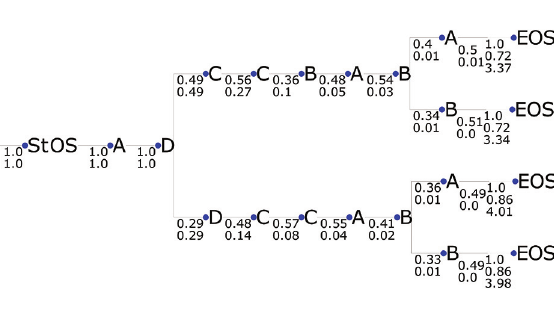
Figure 13: Training statistics on the tree-based system.